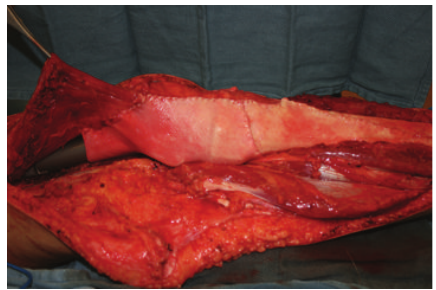
Figure 1: Skeletal reconstruction.